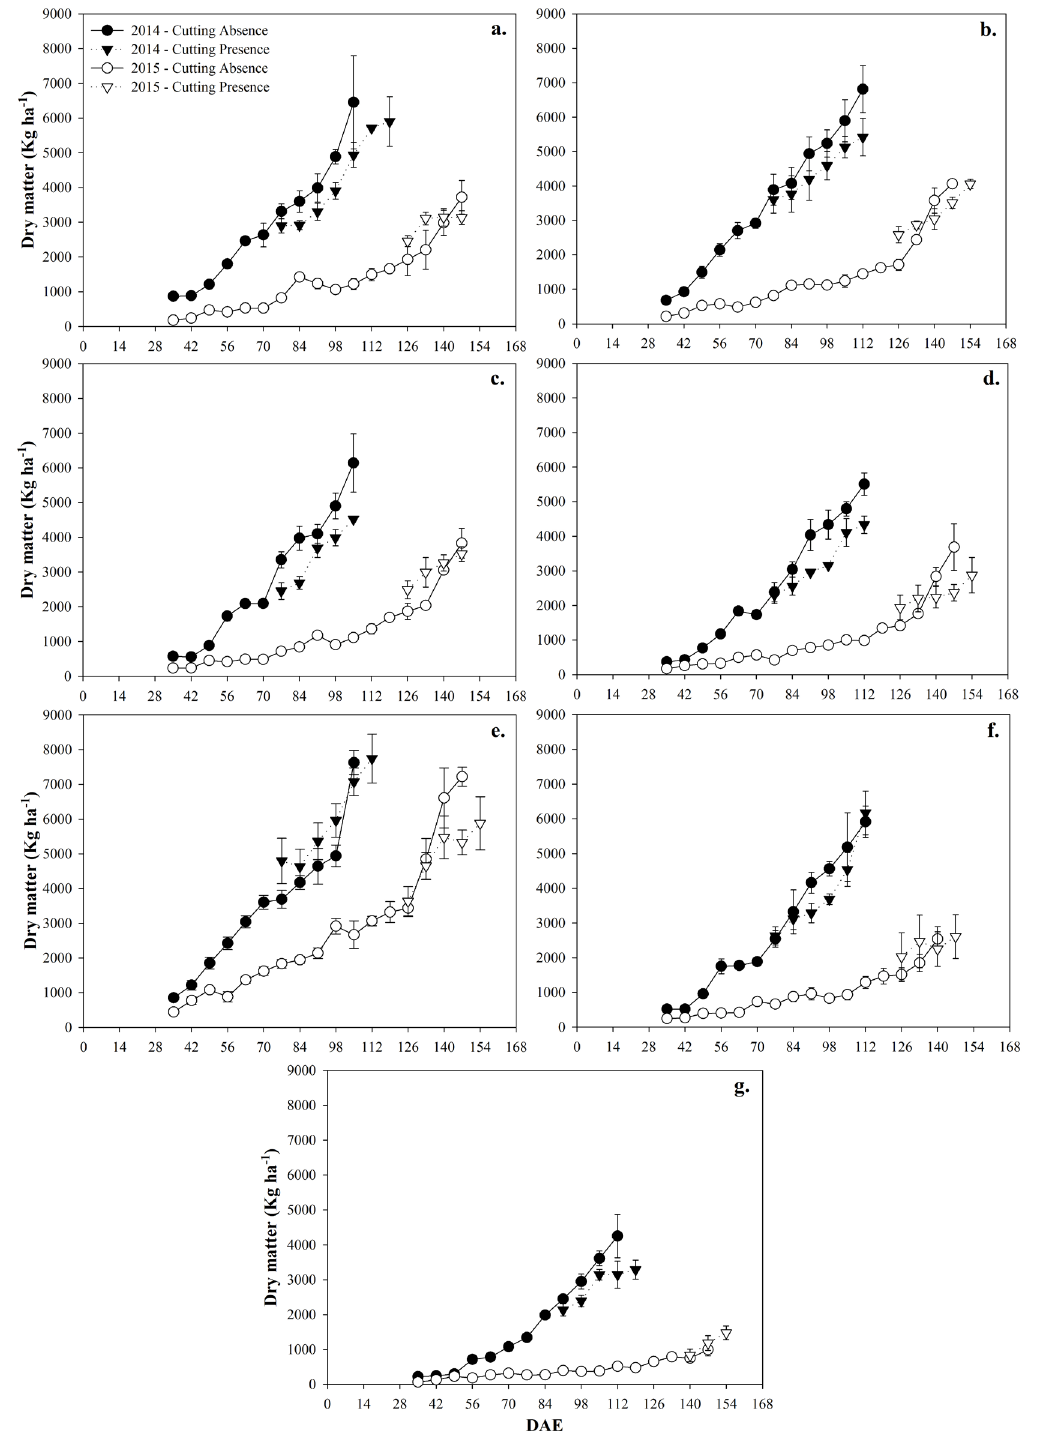
Figure 7 - Dry matter production (TDM) in days after the emergency (DAe) for dual-purpose wheat cultivated in different cropping systems and with or without a cut (grazing simulation) in the crop years of 2014 and 2015 (Crop Season I and II, respectively). S.parahyba Intercrop-I (a) ; P.rigida Intercrop-I (b) ; P.dubium Intercrop-I (c) ; and P.dubium Intercrop-II (d) ; Monoculture (e) ; Eucalyptus Intercrop-II (f) ; and Eucalyptus Intercrop-I (g)